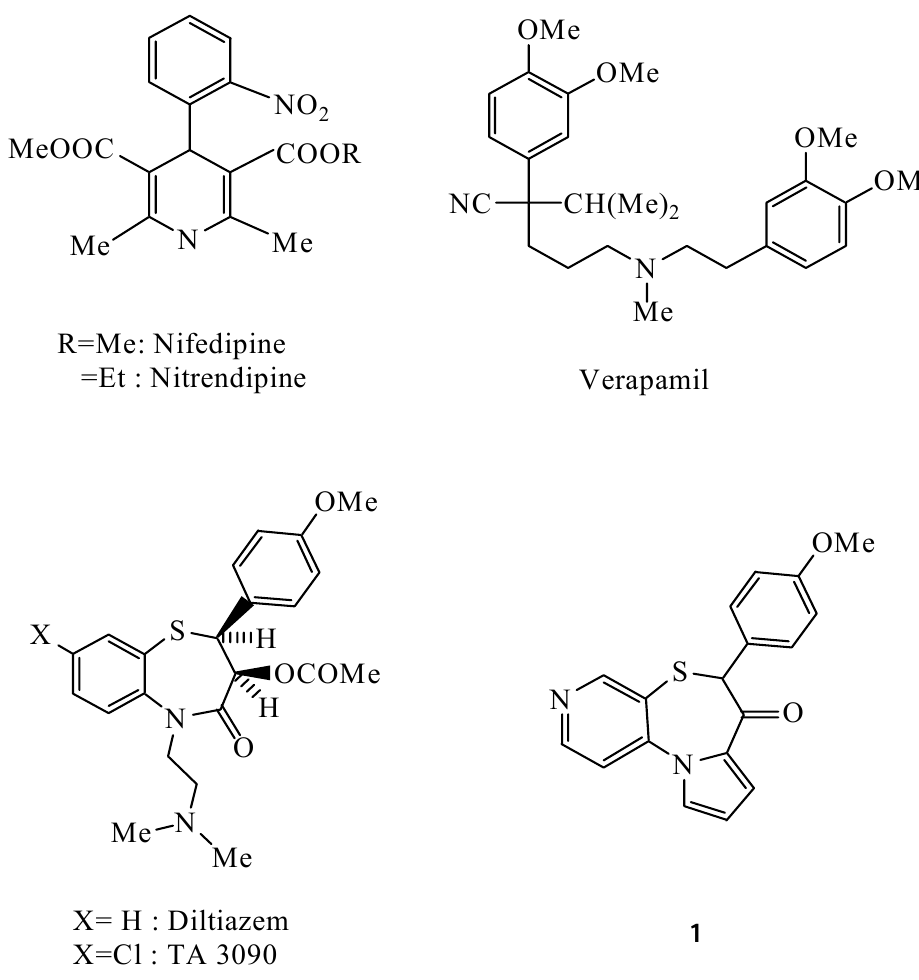
Figure 1 . Representative Ca 2+ channel antagonists and compound 1